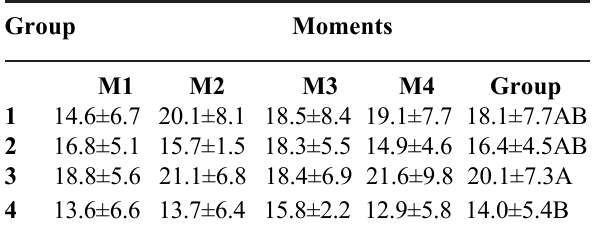
TABLE 3 - Mean and SD values of esophageal distal third contraction amplitude (mmHg) in the four groups at four moments Group